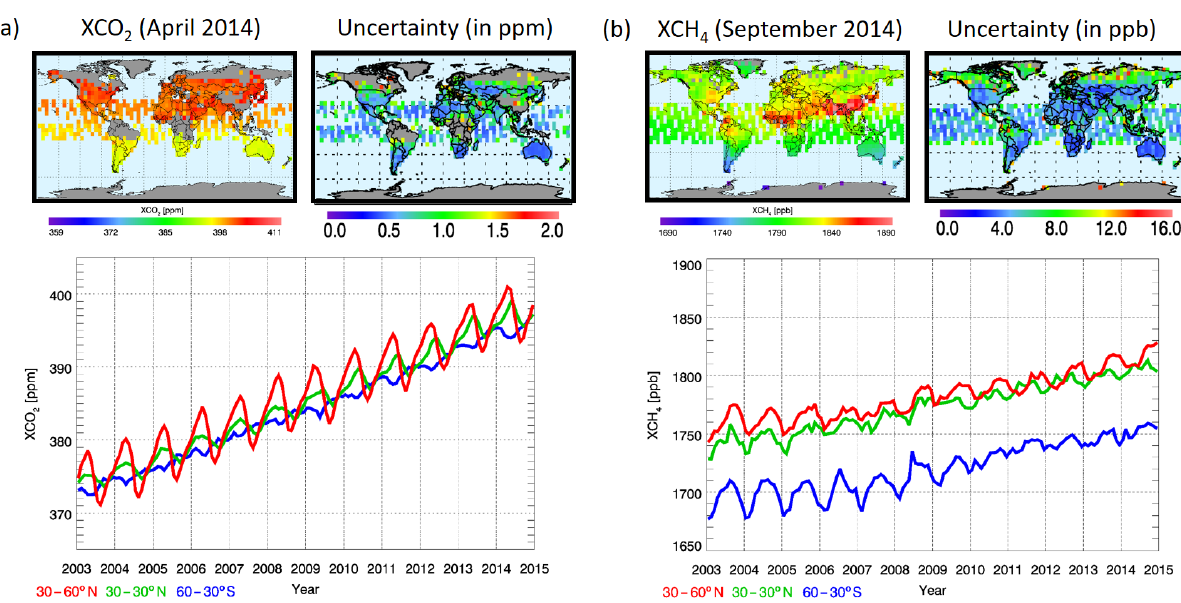
Figure 3. Time series of satellite-derived XCO 2 in three latitude bands (see annotation bottom left, e.g. red line: 30 to 60 ◦ N) and maps showing the spatial distribution of XCO 2 for April 2014 (top left) and corresponding XCO 2 uncertainty (top right). (b) As (a) but for XCH 4 (maps: September